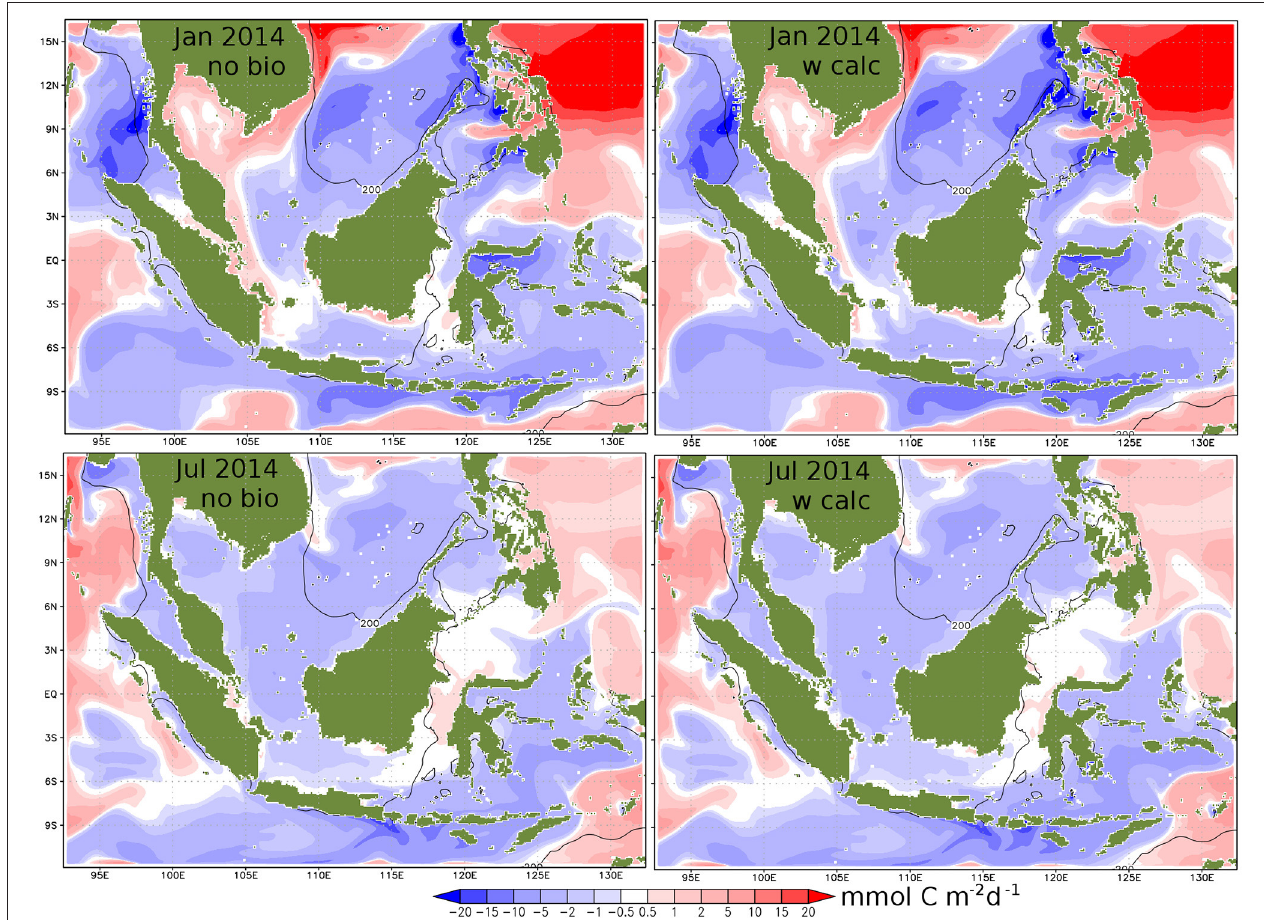
FIGURE 6 | CO 2 flux between ocean and atmosphere (blue: oce ⇒ atm, red: atm ⇒ oce) for a day in January 2014 (upper) and in July 2014 (lower) . Left display simulation results without biology, right with calcification. Maxima are around 25mmolCm − 2 d − 1 in each